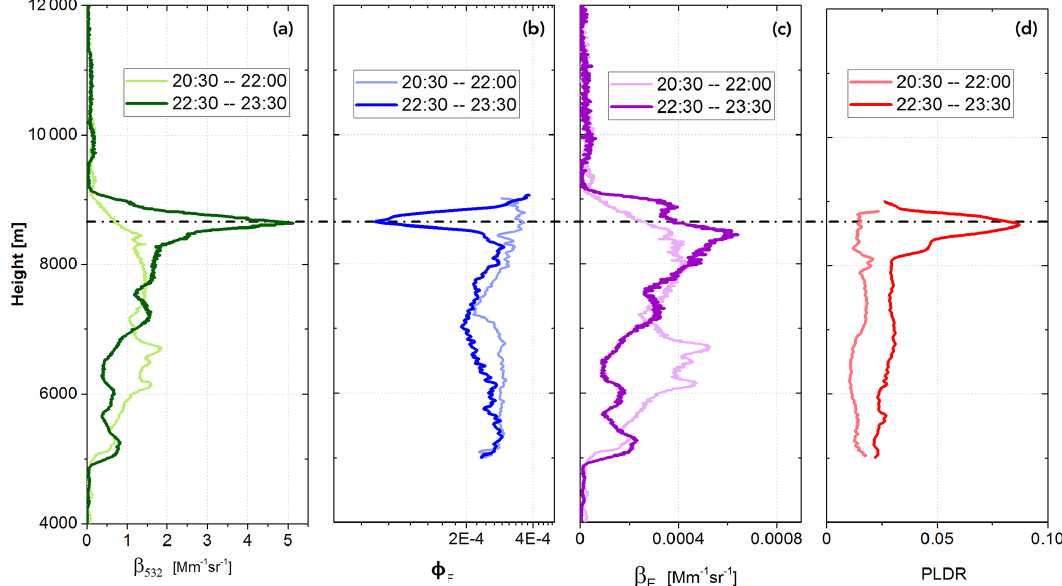
Figure 11. The profiles of averaged parameters in two consecutive periods: 20:30–22:30UTC, 17 September 2020 (before the observation of ice crystals and in lighter colors), and 22:30–23:30UTC, 17 September 2020 (during ice crystal observation and in darker colors). The dashed–dotted line represents the altitude where the ice crystals appeared. (a) Backscattering coefficient at 532nm, (b) fluorescence capacity at 466nm, (c) fluorescence backscattering coefficient and (d) PLDR at